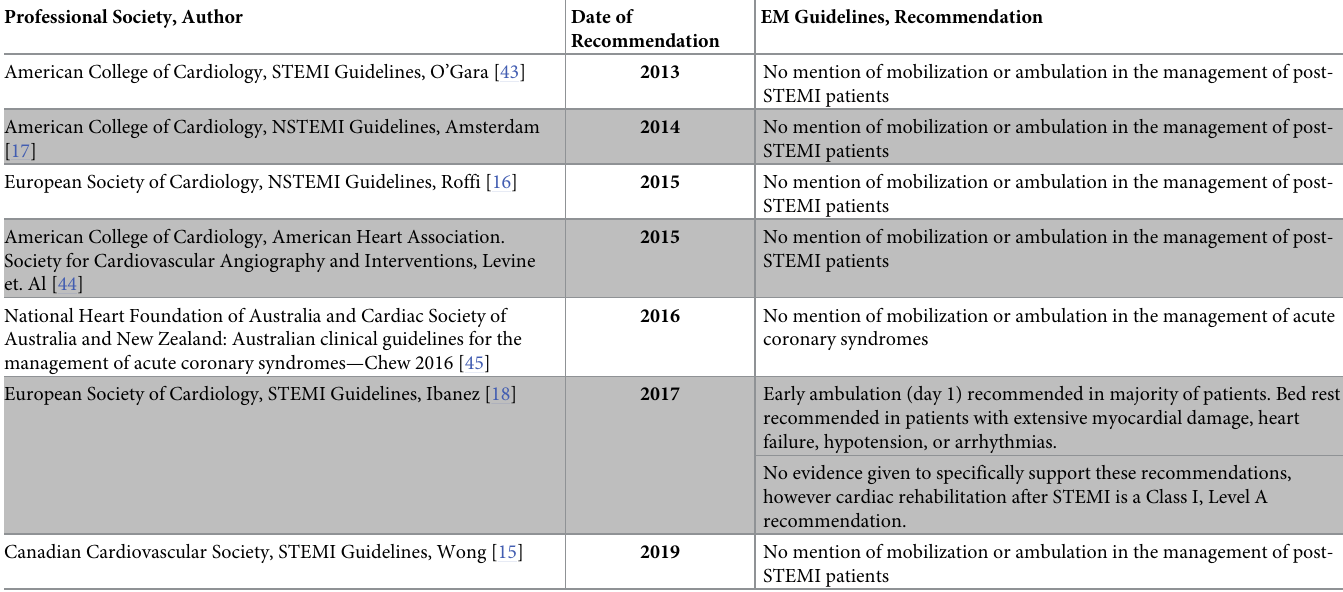
Table 4. Professional cardiovascular society guidelines for early